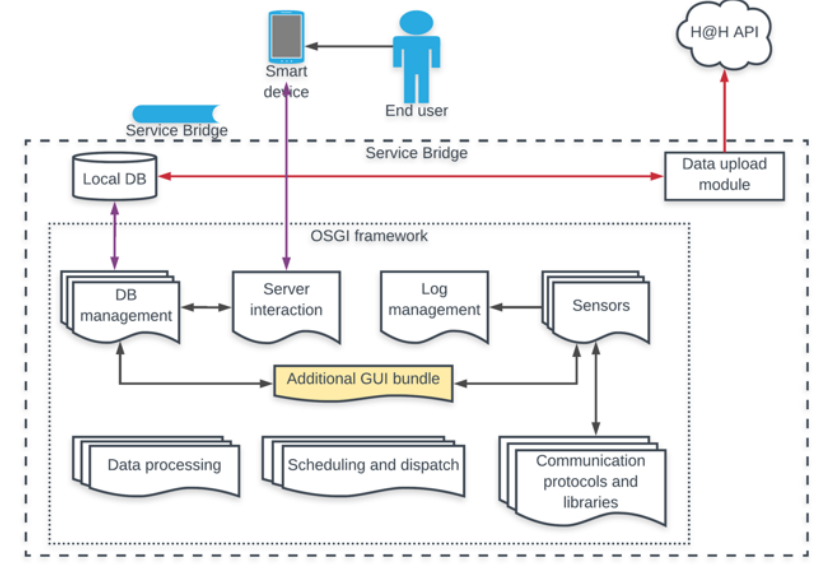
Figure 3. Concept of the Smart Home architecture developed and tested in the pilot